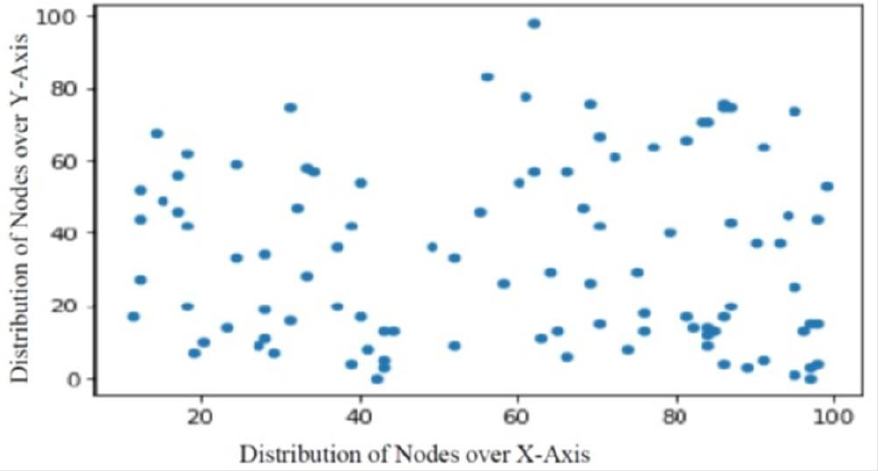
Table 4. Values considering different simulation parameters .